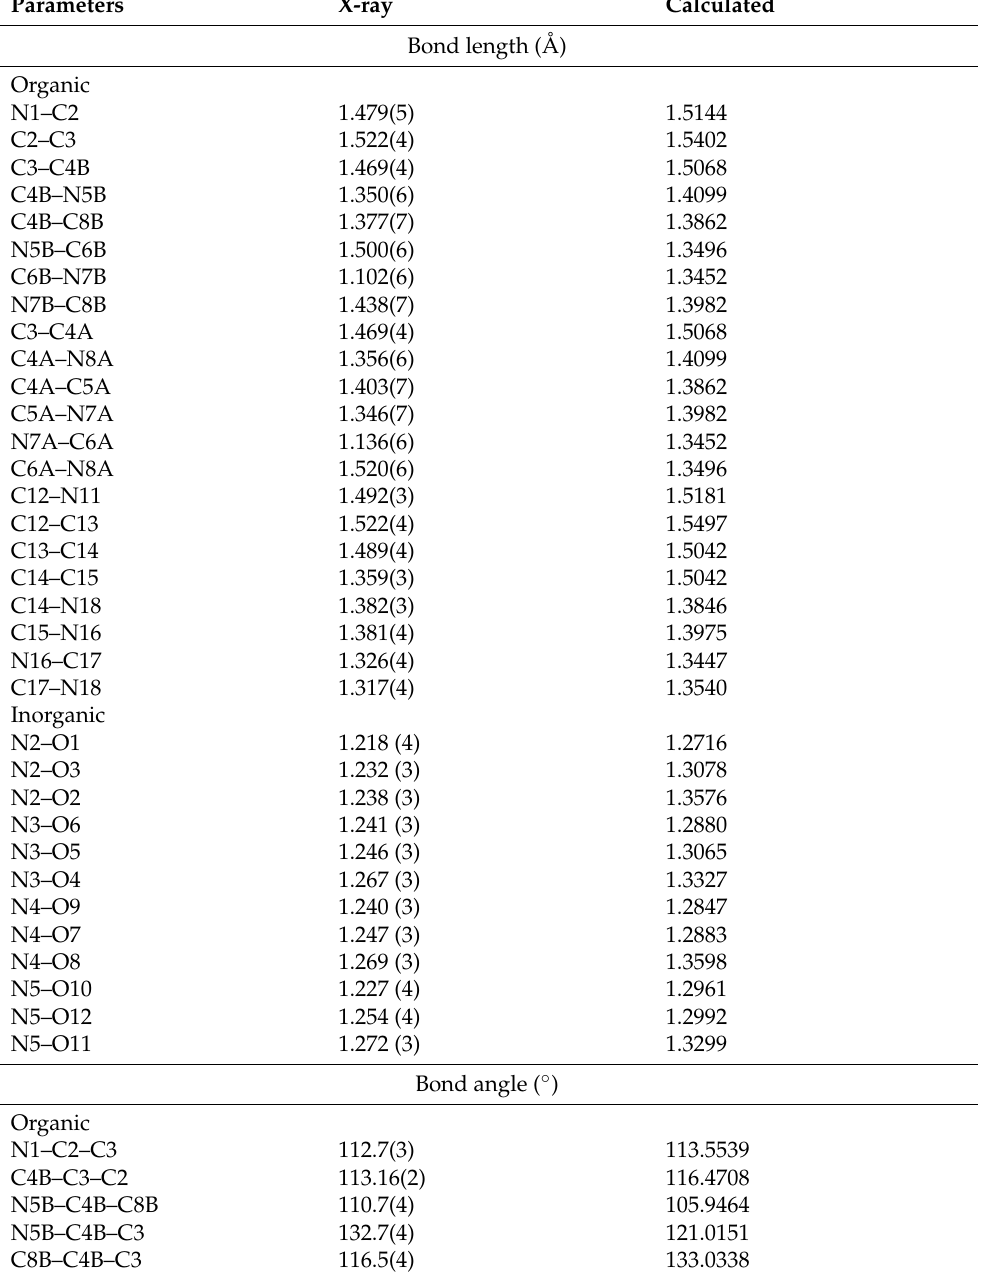
Table 2. Principal intermolecular distances (Å) and bond angles ( ◦ ) in HNT via X-ray data (with estimated standard deviation in parentheses) and via theoretical